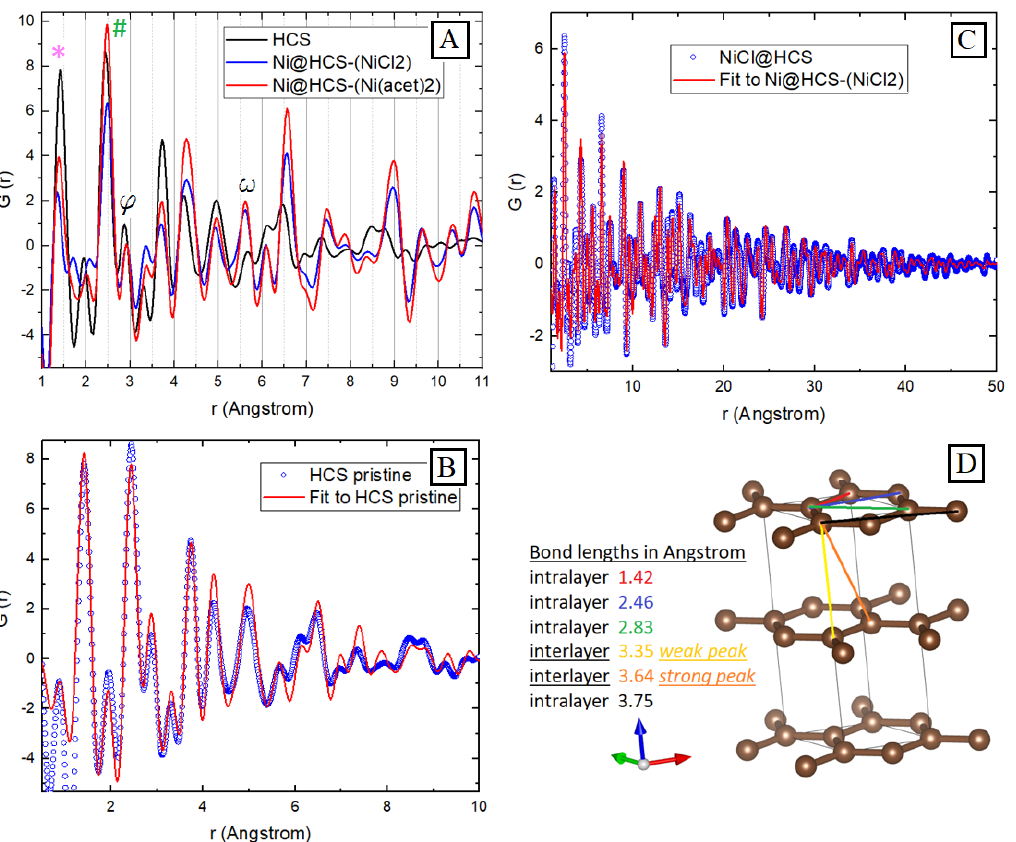
Figure 6. ( A ) Short-medium PDF r(Å) range of the pristine HCS supports and Ni@HCSs nanocatalysts prepared using different Ni-precursors. ( B , C ) Extended PDF r(Å) range showing PDF fits of the HCS and Ni phases for NiCl 2 precursors, respectively. ( D ) Graphite structure and its respective bonding lengths [45].